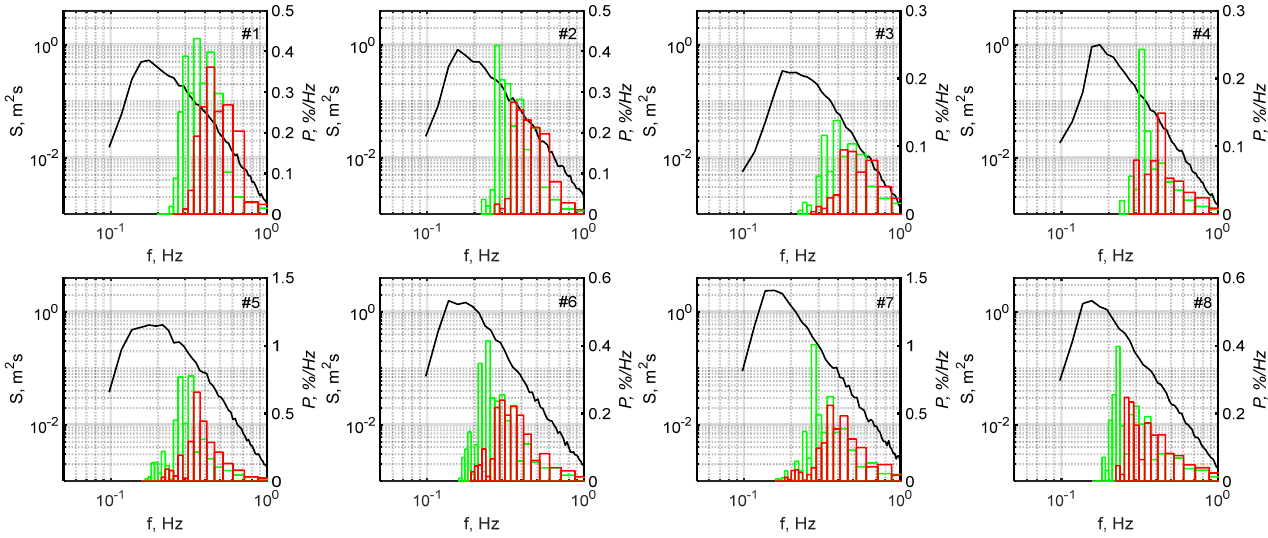
Figure 2. Frequency spectra, S ( f ) , (solid line) and distributions of whitecap coverage over frequency, P ( f ) , for c b = c (red bars) and for c b = 0.8 c (green bars) for all experimental